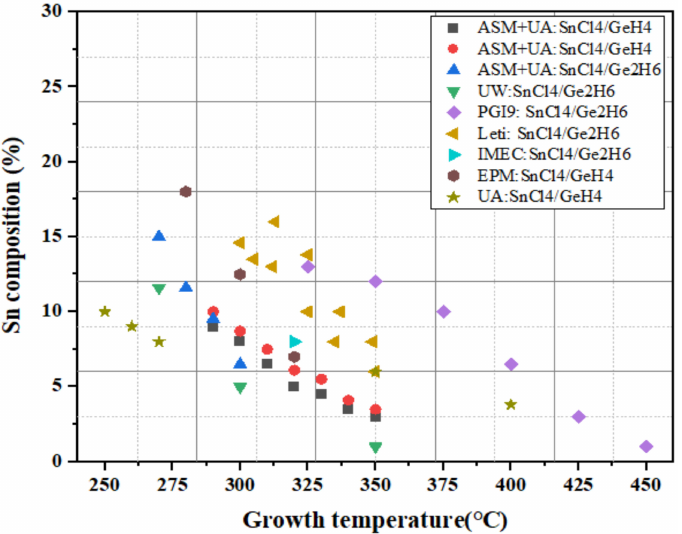
Figure 7. Temperature effect on the Sn content from different research groups (UW, UA, and EPM denote the University of Warwick, University of Arkansas, and Universit é de Montr é al, respec- tively) [113,115–117,151–156].